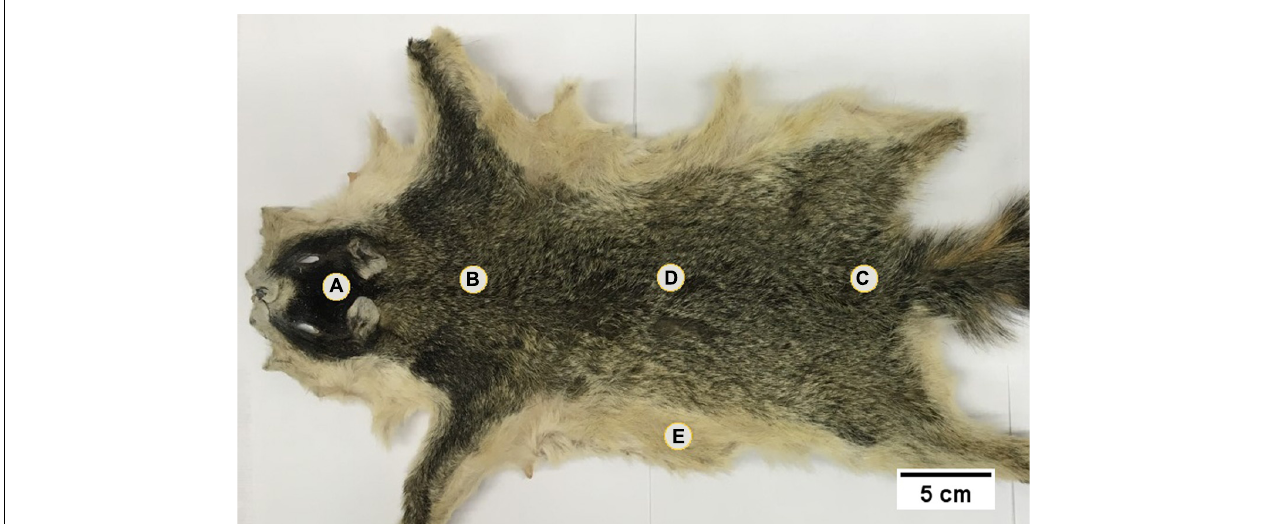
FIGURE 3 | An example of an eastern fox squirrel specimen used to investigate the environmental drivers of color polymorphism. Each circle, scaled to 15 mm diameter, shows the location where we measured coloration using a handheld digital color sensor ( (A) = Head, (B) = Shoulder, (C) = Rump, (D) = Dorsum, (E) =